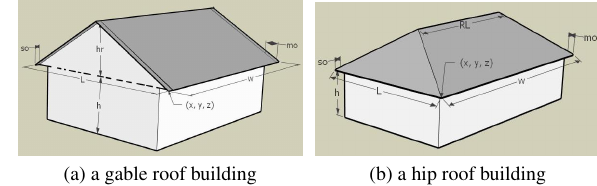
Figure 1: Parametric building models with overhang